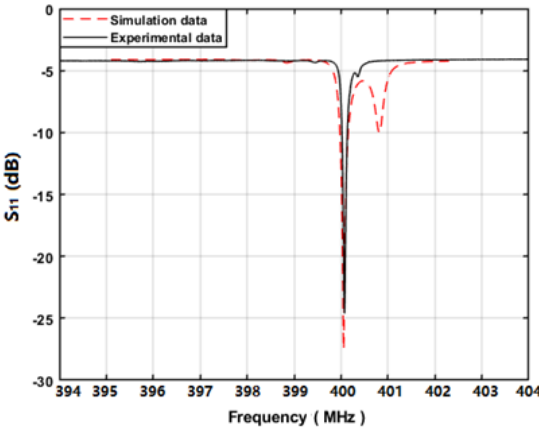
Figure 14. The measured S 11 of the prepared SAW sensing devices.